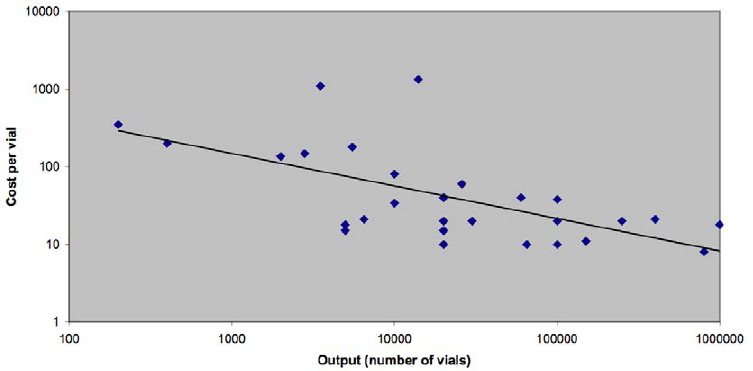
Figure 1. Antivenom price v output. Economies of scale mean that the cost per ampoule decreases as throughput increases.